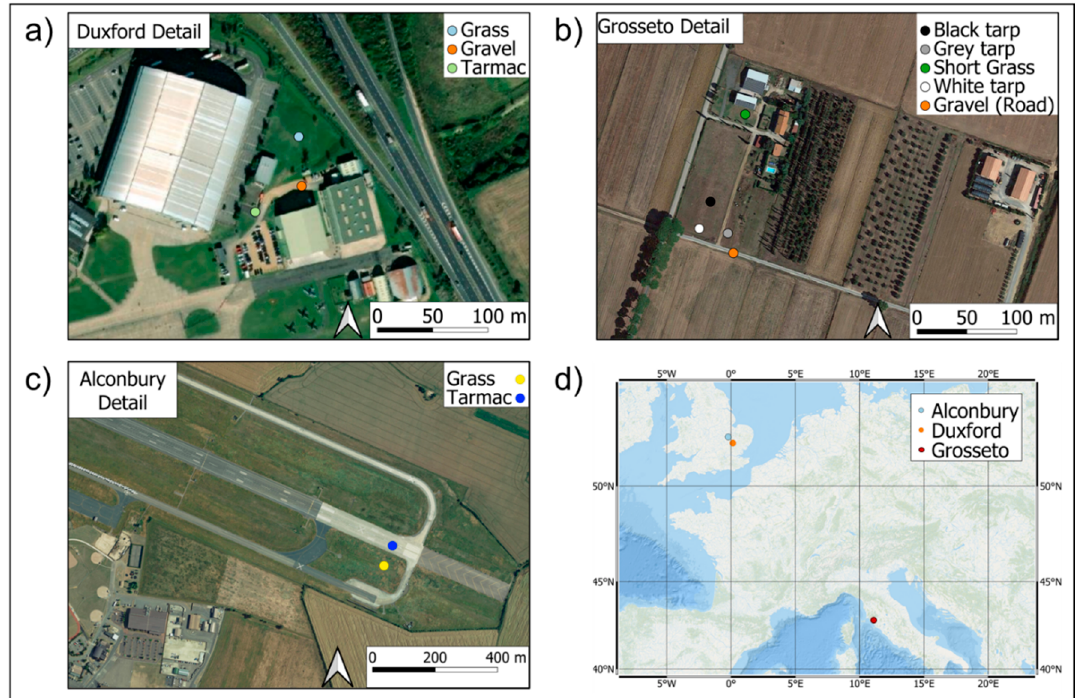
Figure 6. Sites in the UK and Italy where the study measurements took place, showing ( a ) detail of Duxford where measurements of grass, gravel, tarmac, and the tarpaulins were collected; ( b ) detail of Grosseto indicating locations of the same tarpaulin measurements there; ( c ) detail of the runway area at Alconbury, showing the grass and the tarmac where all non-grass samples were placed for field measurement, and ( d ) the relative locations of the three field sites.